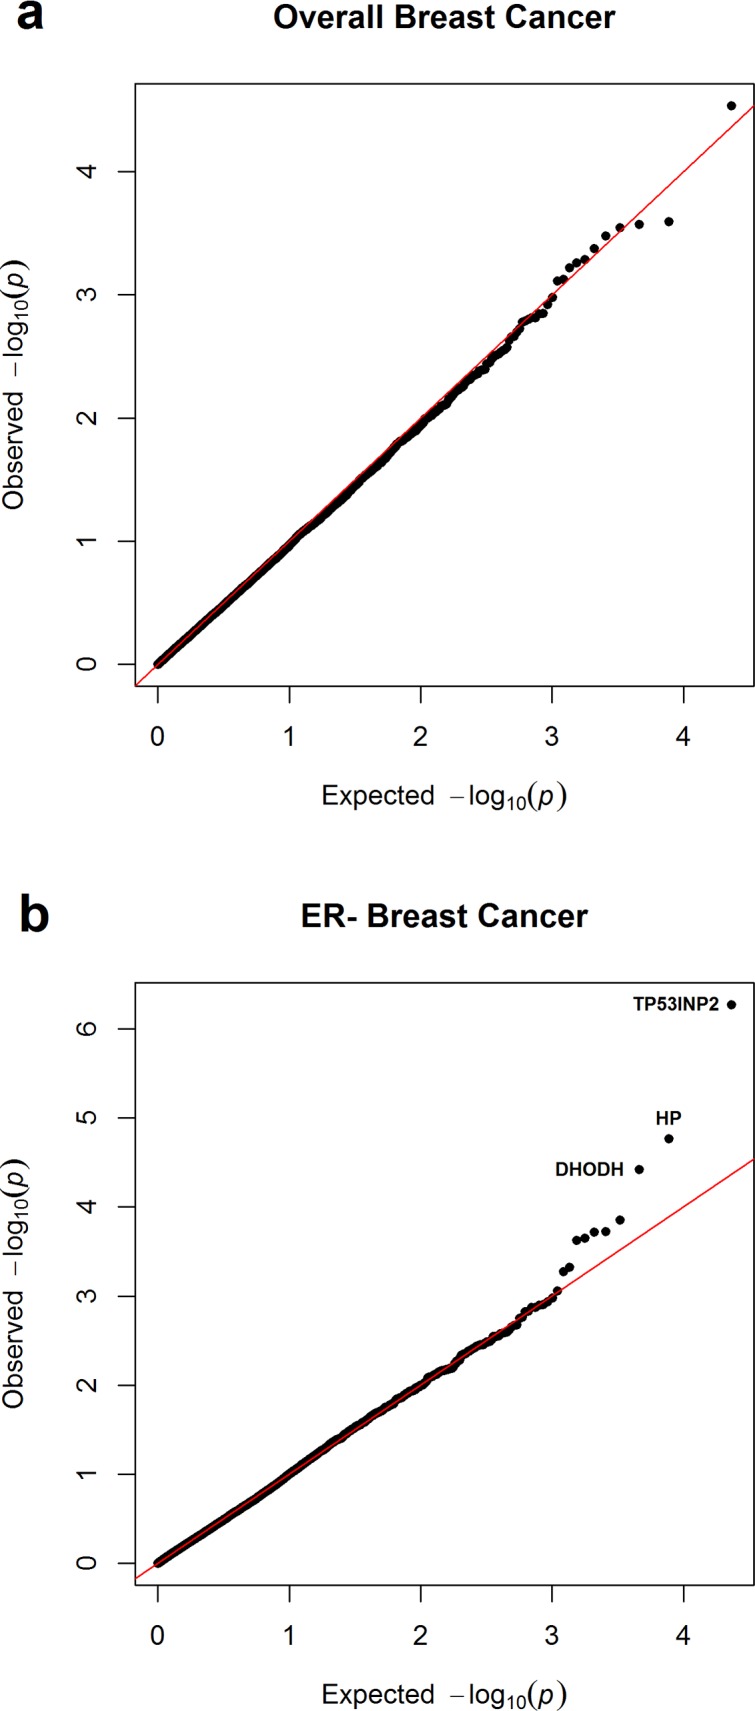
Quantile-quantile plot of gene-based association P values for (a) overall and (b) estrogen receptor negative breast cancer. Red line shows the null distribution of P values.